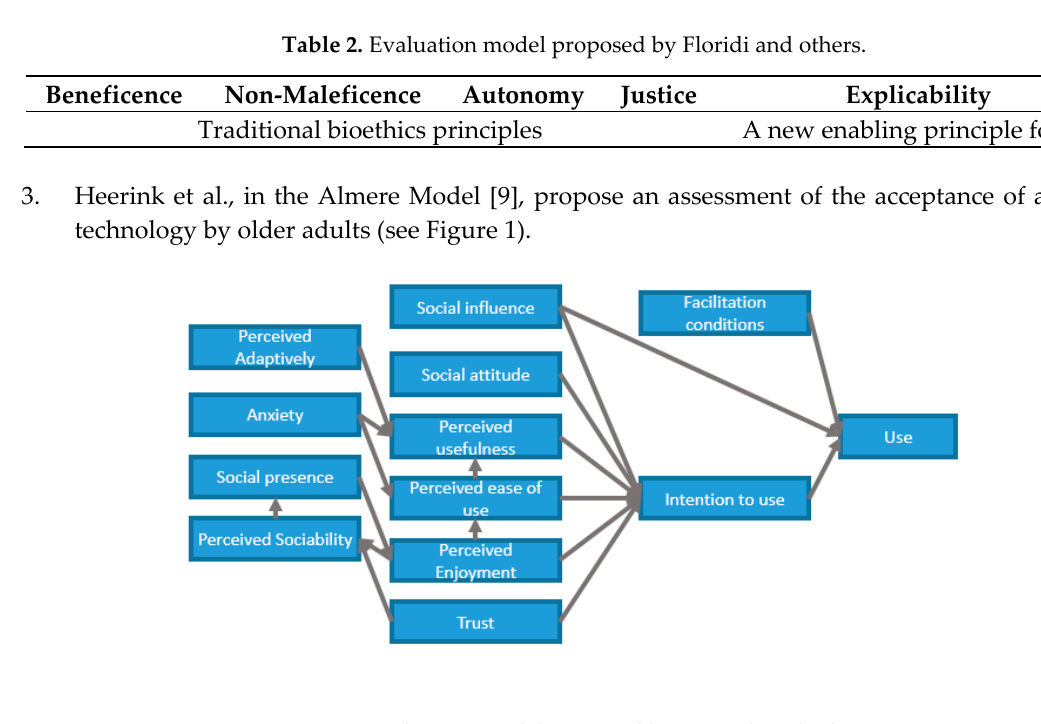
Figure 1. Evaluation model proposed by Heerink and